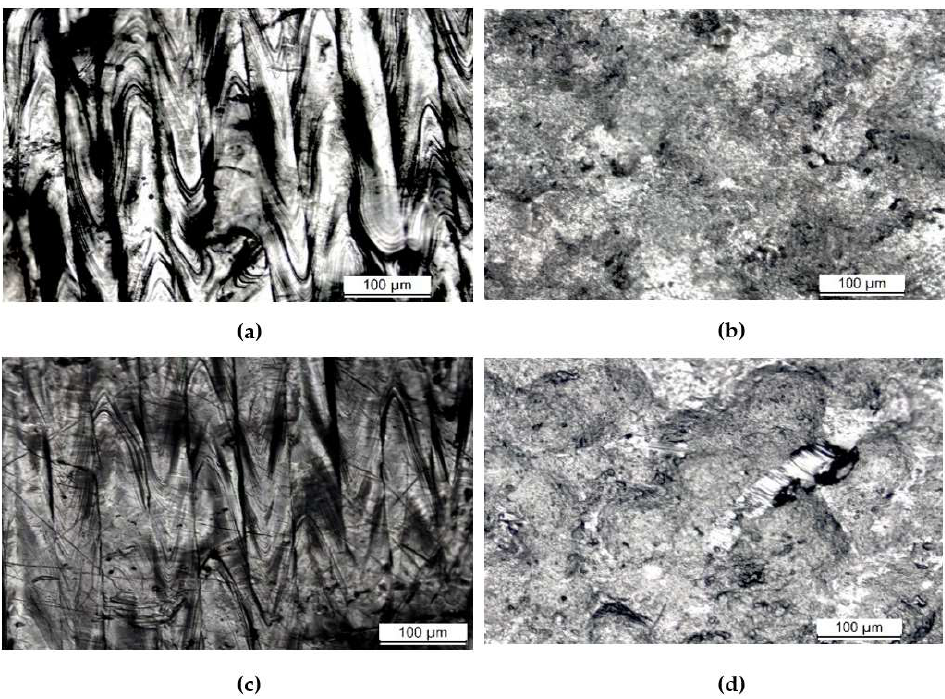
Figure 6. Micrographs for the surface: ( a ) AP ( b ) PSP ( c ) PC and ( d ) PSPC.